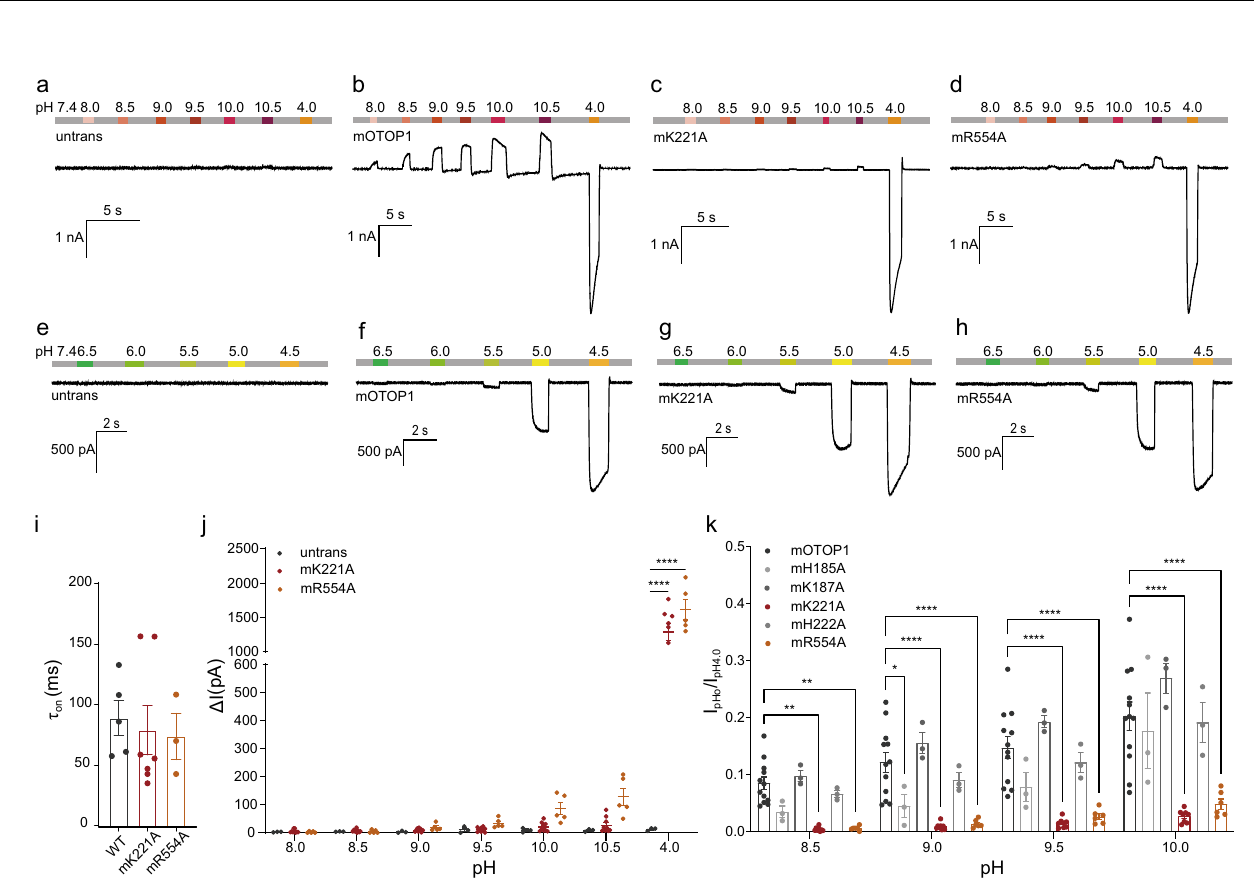
Fig. 1 | Characterization of mOTOP1 channel alkali activation. a Representative current traces induced in mOTOP1-expressing and untransfected HEK293T cells were applied by different alkaline solutions. Untrans, untransfected. b Plot of normalizedcurrents( I pHtest / I pH4.0 )versuspHinOTOP1channels(mean±SEM, n =4 cells). Membrane potential ( V m )=0mV. c Zn 2+ concentration responses were shownforwild-typemOTOP1channels.Datapointsrepresentmean±SEM,andthe pink line represents the fi t of the mean data by a Hill function. n = 3 – 5 cells. d I – V relationships of mOTOP1 channels were recorded from pH 7.4 extracellular solu- tion to alkaline extracellular solution at different pH values. e E rev as a function of pH in the experiments of ( d ). The E M means were well fi tted by linear regression with the slope of − 61.86mV/pH ( R 2 =0.9972). E M , E Measured ; E H , E Holding potential . mean±SEM. n = 5 – 9 cells. f pH fl uorescence images of untransfected and mOTOP1-expressing cells stimulated with pH 4.0 and 9.5. Scale bar, 50 μ m. Cells